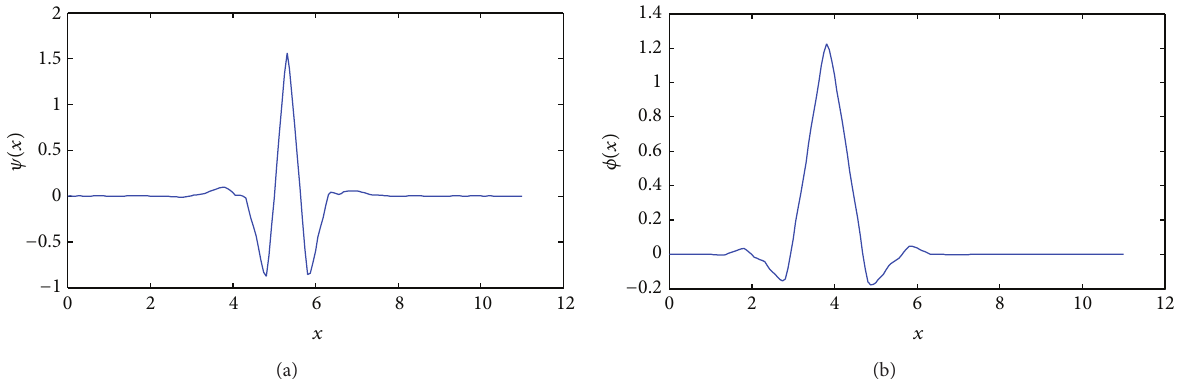
Figure 2: An example of wavelets. (a) Coiflets. (b) Scaling function of Coiflets.